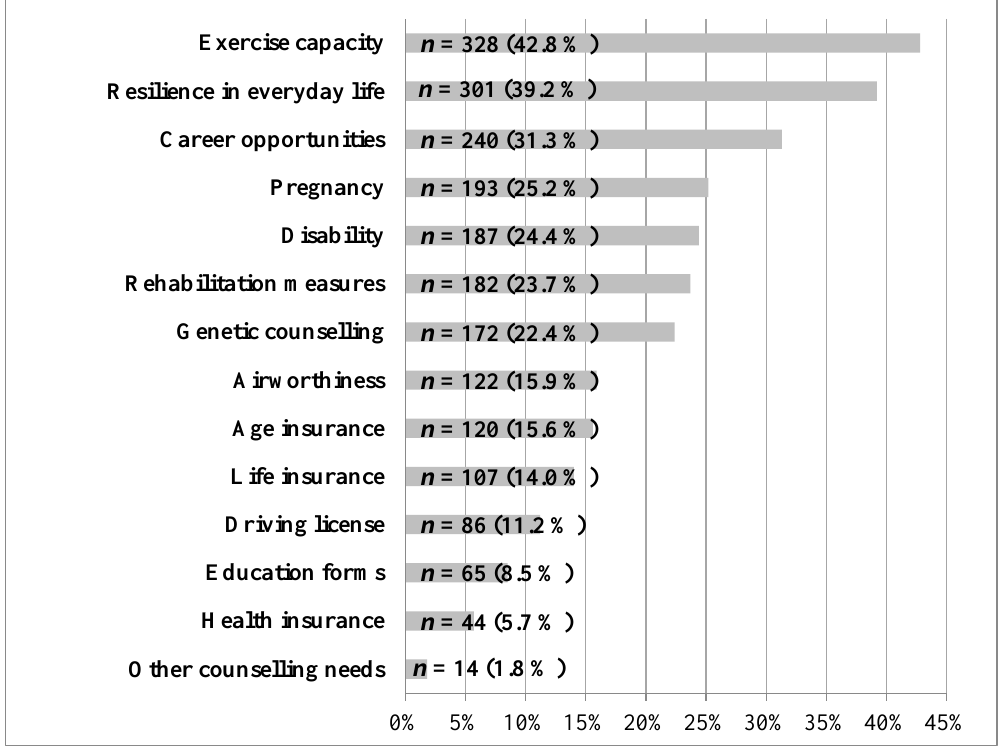
Figure 2. Consultation needs of adults with congenital heart disease, from the primary care physicians’ perspective (multiple answers possible); n = absolute number.